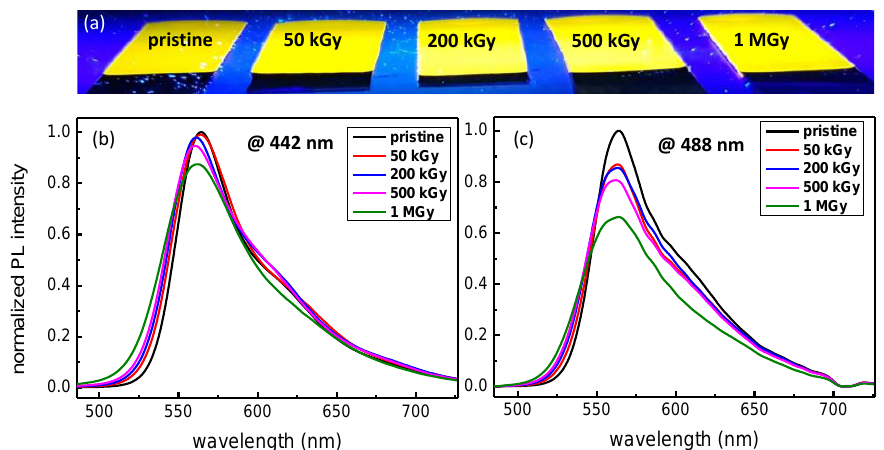
Figure 6. PL study of TiO 2 -SiO 2 sol-gel doped with R6G exposed to γ -rays with accumulated doses of 50 kGy, 200 kGy, 500 kGy and 1 MGy. Visual observation under a 365 nm (8 W) excitation ( a ). PL spectra under excitation at 442 nm ( b ). PL spectra under excitation at 488 nm ( c ). The power densities are 58 W/cm 2 and 25 W/cm 2 for the 442 nm and 488 nm excitation while the exposure time is 1 s. It is to note that the PL was normalized with respect to the maximum PL intensity obtained for the pristine sample.